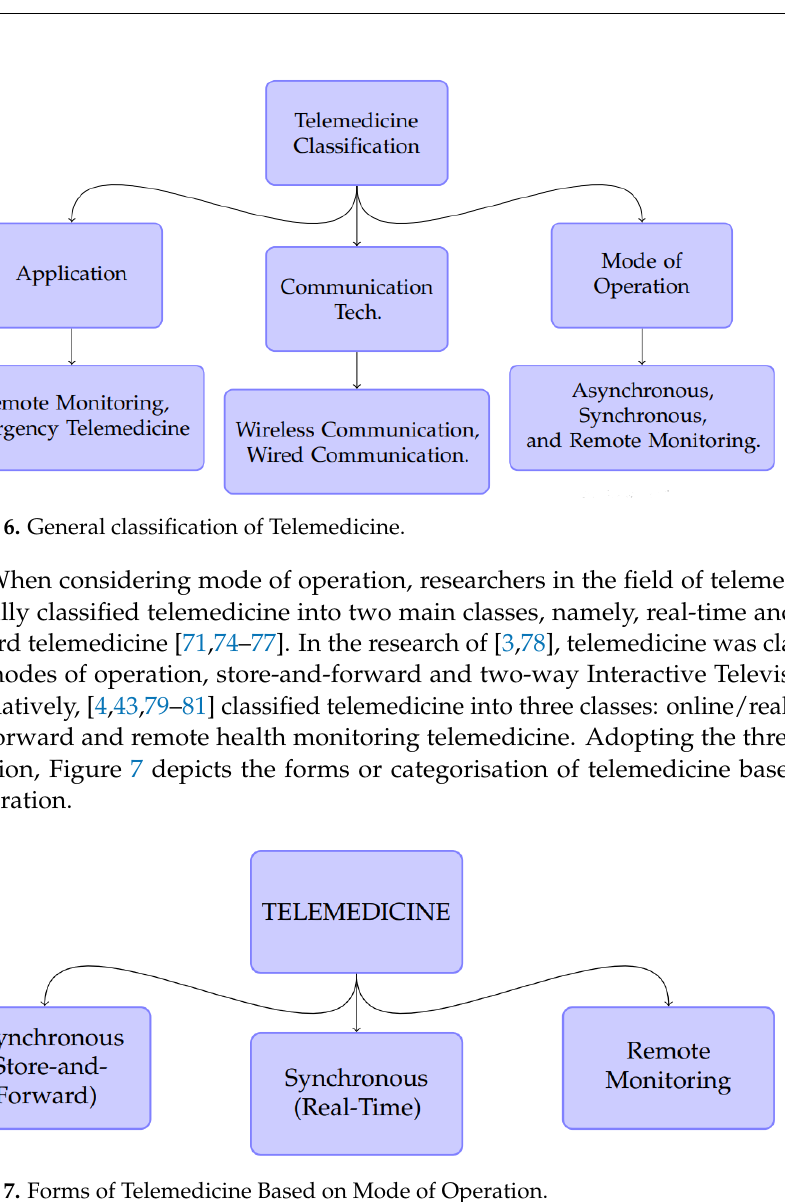
Figure 7. Forms of Telemedicine Based on Mode of